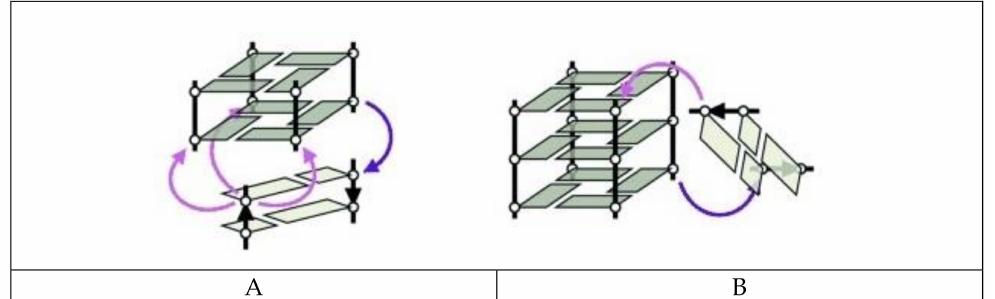
Figure 1. The coaxial ( A ) and orthogonal ( B ) types of quadruplex–duplex junctions with a fixed (purple) or variable (pink) point of conjugation, according to [36]. Reproduced by permission from John Wiley and Sons, © 2013 Wiley-VCH Verlag GmbH & Co. KGaA,